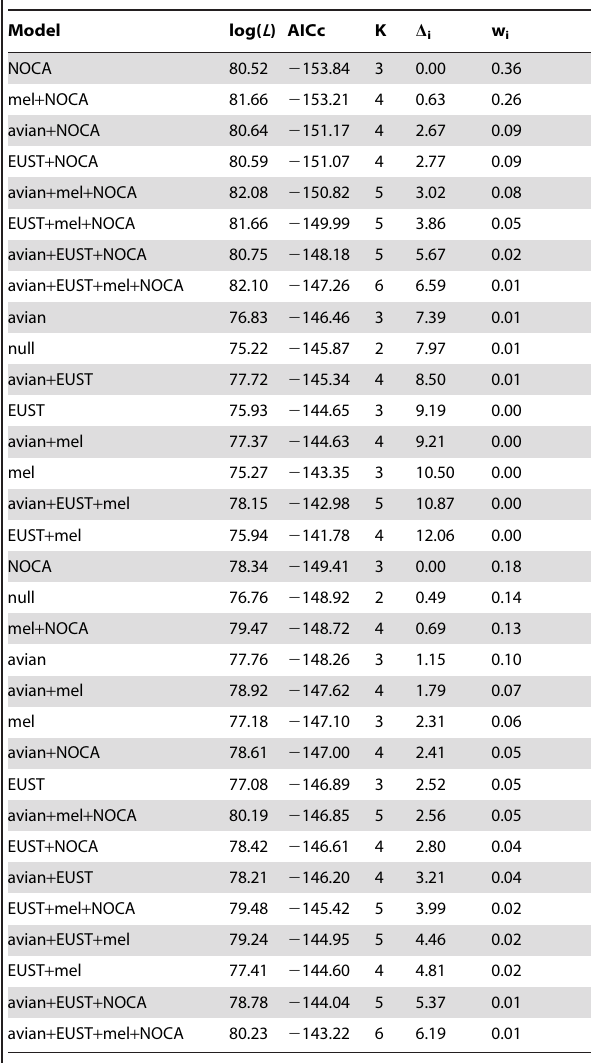
Table 1. Attributes of highest-ranking models in candidate set used in spatial modeling of EEEV exposure risk in sentinel chickens in Walton County, Florida in 2009 and